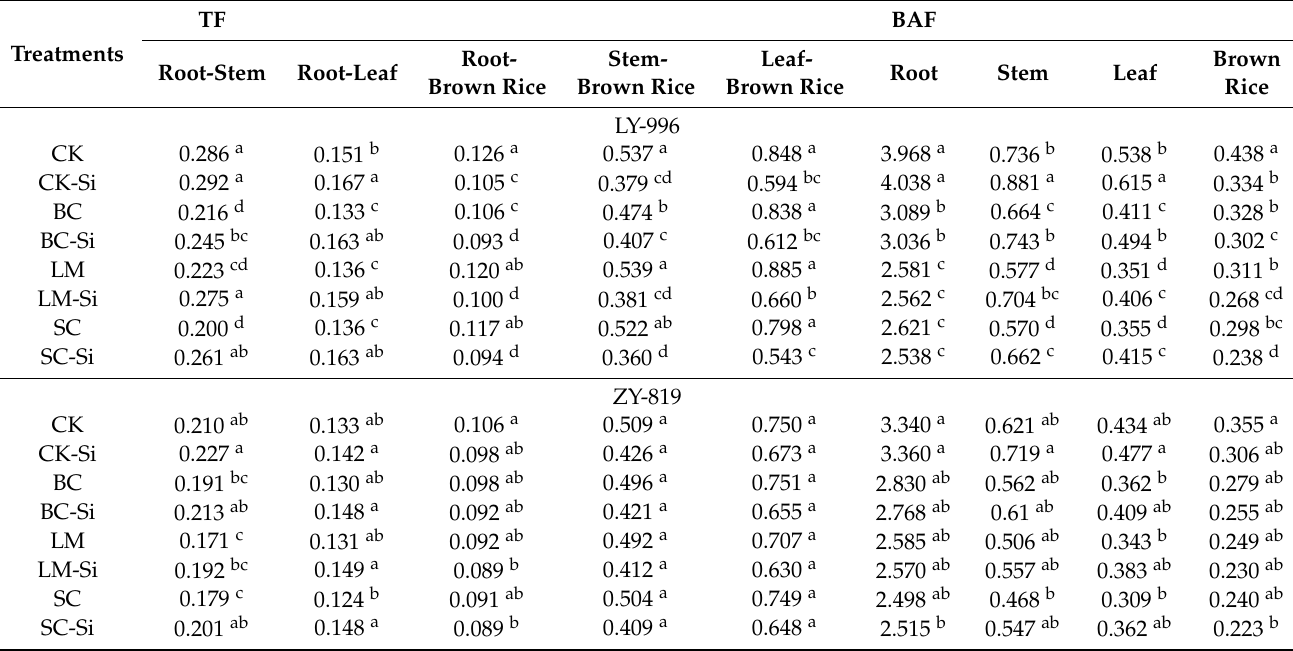
Table 3. Translocation factors (TFs) and bioaccumulation factors (BAFs) for Cd for different parts of the early rice plants.